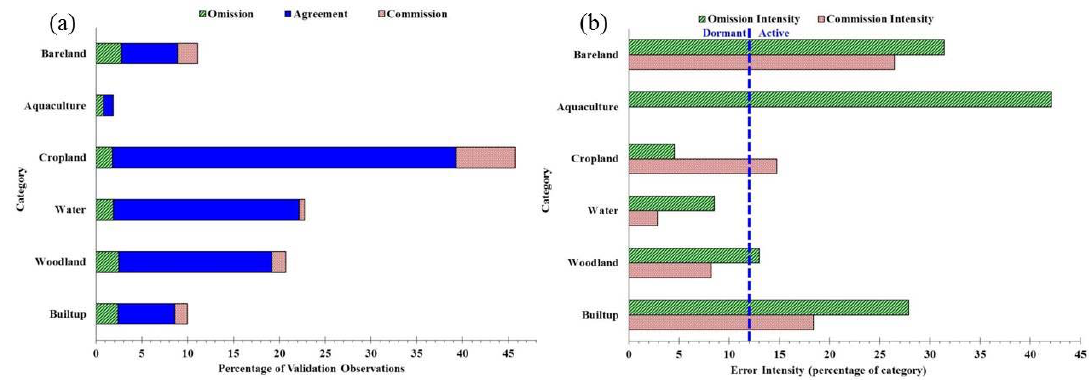
Figure 5. Category level errors at 2016 for ( a ) size and ( b ) intensity. The dashed line is the error overall, as a percentage of Nanchang validation observations.